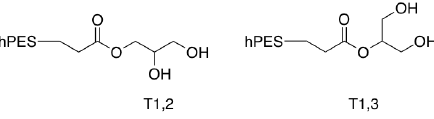
Figure A2. Terminal glycerol units of hPES-OH 2 .